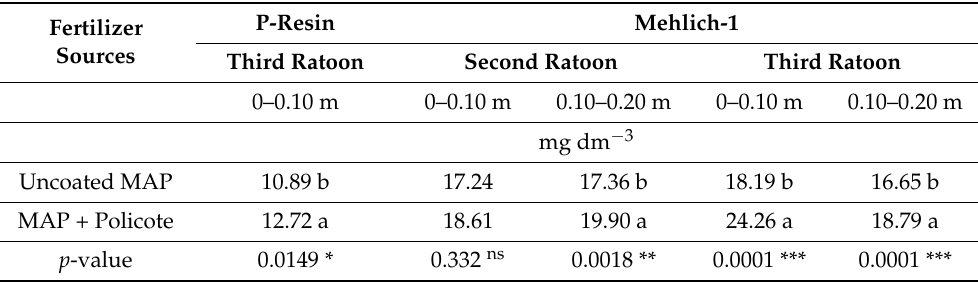
Table 2. Mean soil phosphorus contents extracted with P-Resin and Mehlich-1 after sugarcane cultivation in the second and third ratoon crops fertilized with phosphorus sources with and without Policote coating. Growing seasons 2018/2019 and 2019/2020.